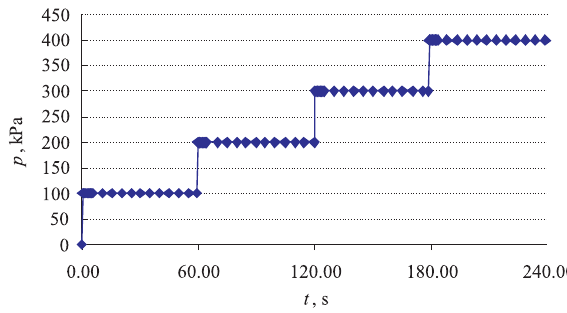
Fig. 3. Loading history for Samples 1–4